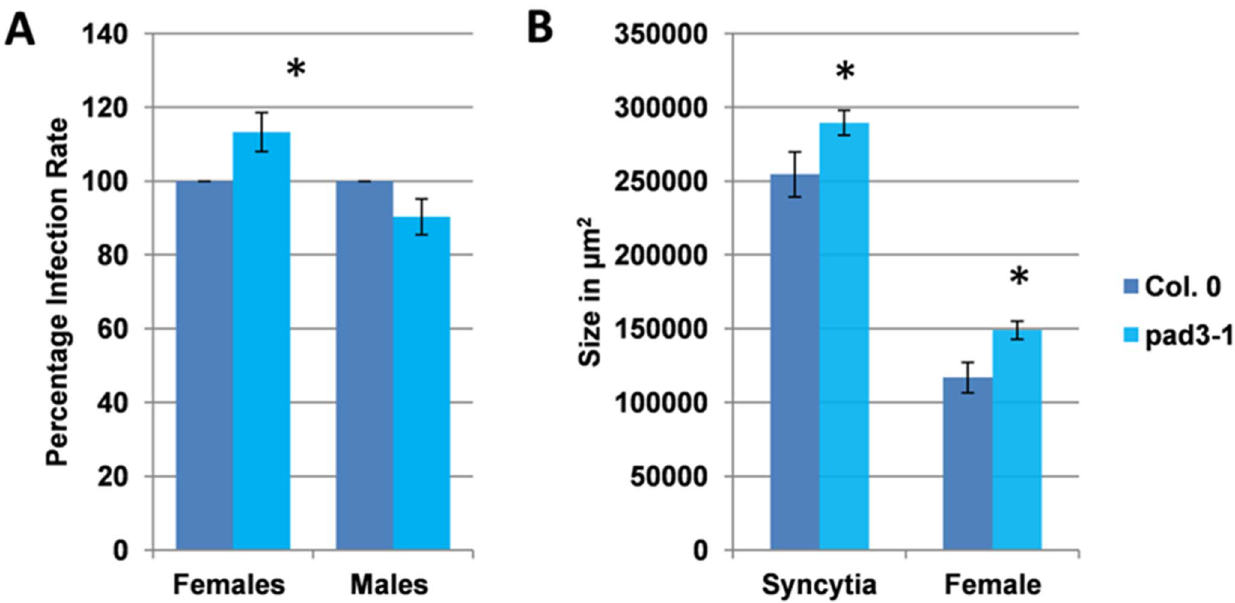
Figure 9. The pad3 mutant is more susceptible. The resistance of pad3 knock out mutant compared to wild type plants after infection with H. schachtii . A: Number of male and female nemaodes per cm of root length calculated at 15 dpi setting the wild type as 100%. Asterisks indicate significant differences (P , 0.05; T-test). The statistical significance was determined by three independent replicates. Values are means 6 SE, n=15. The bar shows standard error for the mean. B: Size of female syncytia and female nematodes at 14 dpi. Ten syncytia were selected randomly from three independent replicates (total=30) and the size of syncytia and associated female nematodes was determined. Data were analysed for significance difference using T-test. Values are means 6 SE.